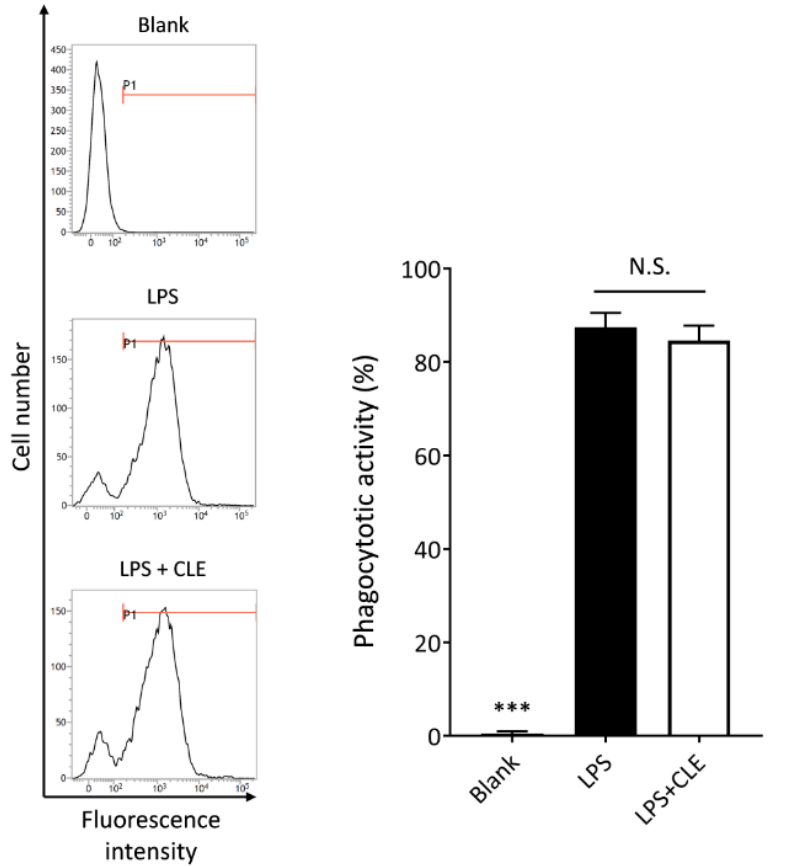
Figure 5. Effect of an aqueous extract from leaves of Citrus unshiu (CLE) on the phagocytotic activity of RAW 264.7 cells. RAW 264.7 cells were treated with 1.25 mg/mL of CLE for 24 h, followed by LPS stimulation for 1 h. The cells were next treated with Texas Red-conjugated Zymosan A for 24 h. The phagocytotic activity was then analyzed by flow cytometry. LPS indicates the LPS-stimulated cells treated with water instead of CLE, while blank indicates the cells not stimulated with LPS. Data are represented as mean ± SEM ( n = 3). *** p < 0.001 against LPS by Dunnett’s test. N.S. indicates no statistical significance against LPS by Dunnett’s test.